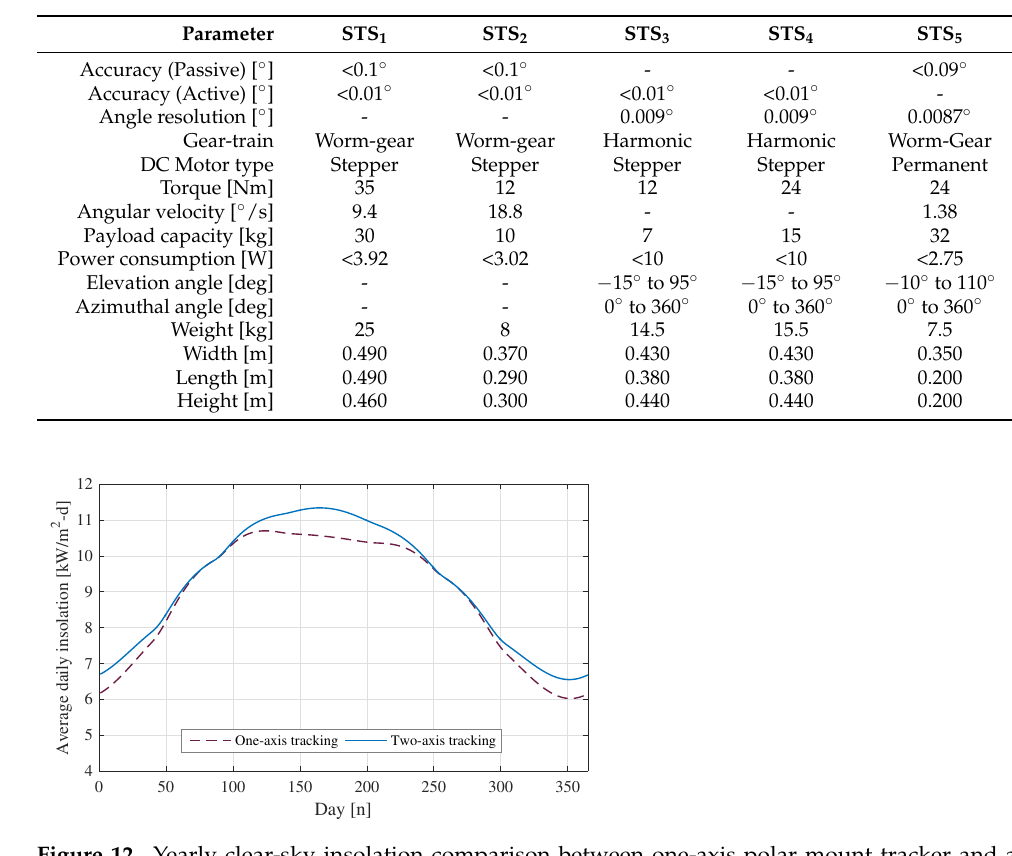
Table 7. Summarized parameters of commercial and developed STS.